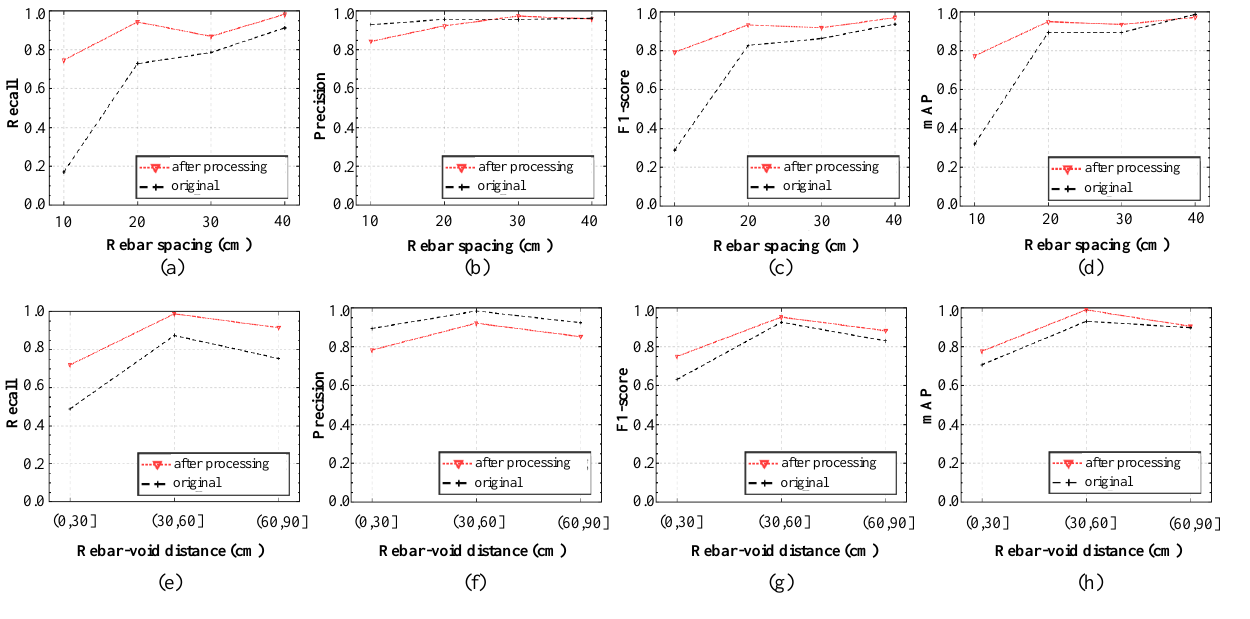
Figure 10. Evaluation metrics of the detection network calculated on ( a – d ) testing dataset I, and ( e – h ) testing dataset